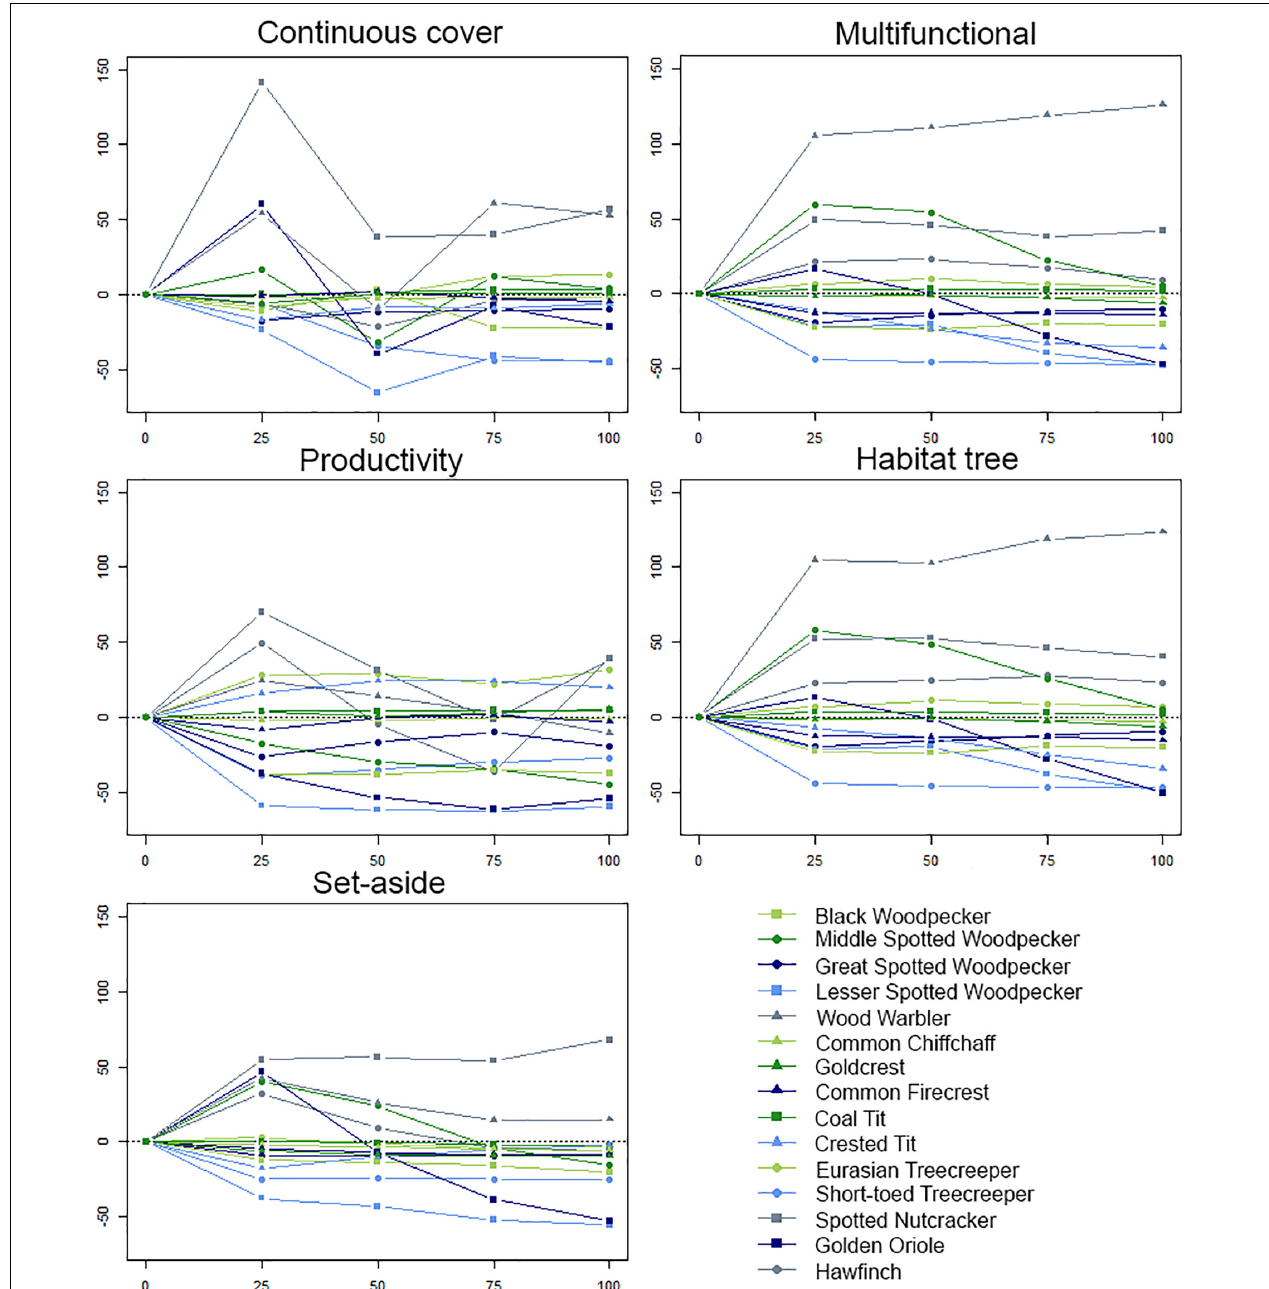
FIGURE 3 | Change in mean predicted probability of occurrence (in percentage) of our studied species across the entire study area, for the five forest management scenarios considered, 100 year into the